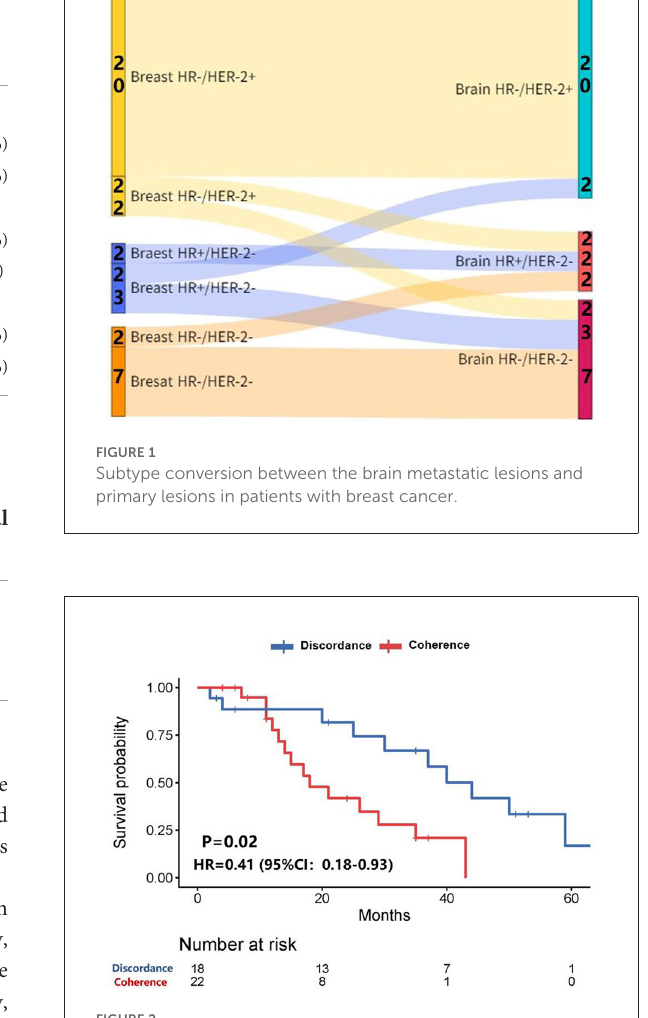
FIGURE2 Survival curves of patients with consistent expression of anyone receptor vs. patients with inconsistent expression of anyone receptor after diagnosis of brain